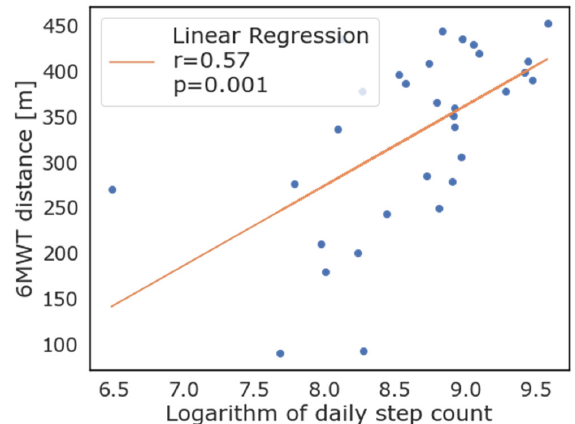
Figure 4. Correlation between logarithmic transformation of daily steps as measured by wearable devices and 6 ‐ minute walking test.